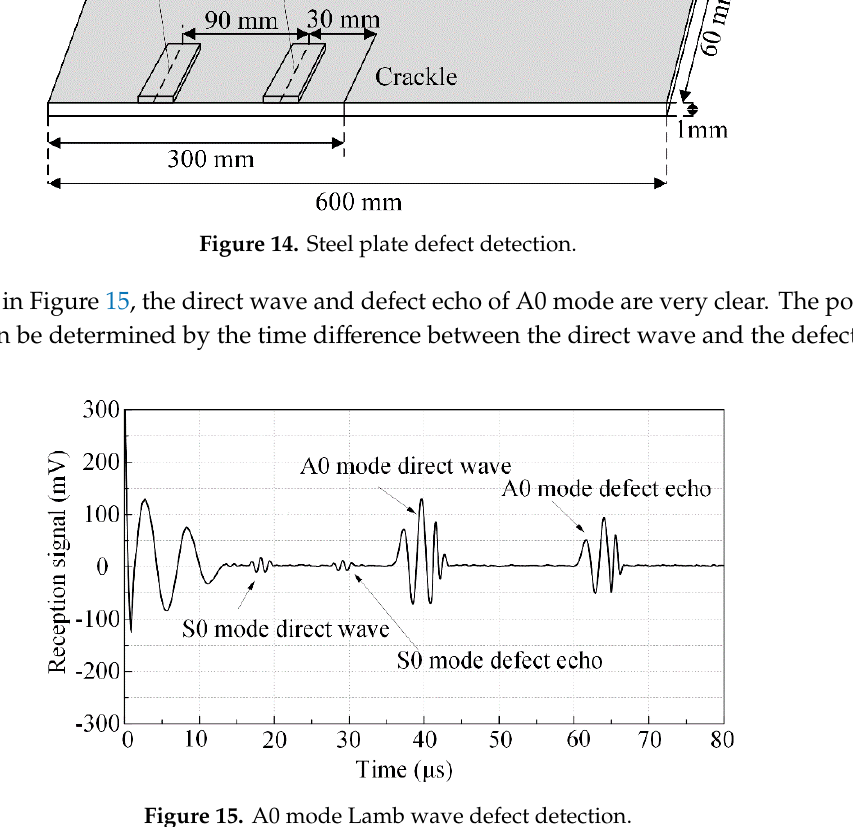
Figure 13. The A0 and S0 modes received signal change with the lift-off distance.